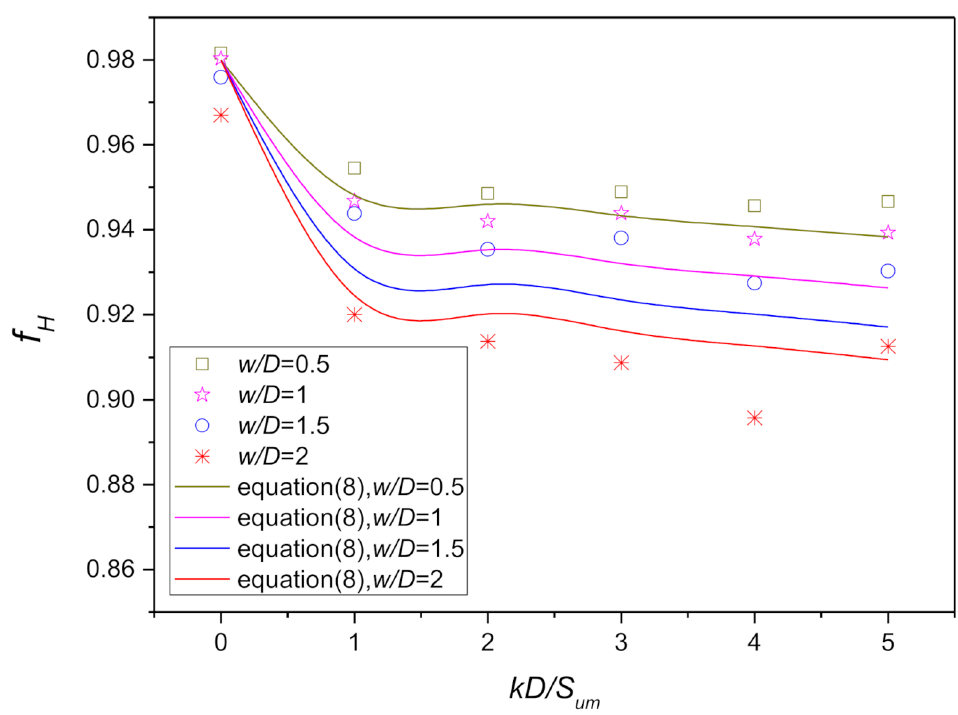
Figure 24. Reduction factors of horizontal dimensionless elastic stiffness coefficients related to kD and w D